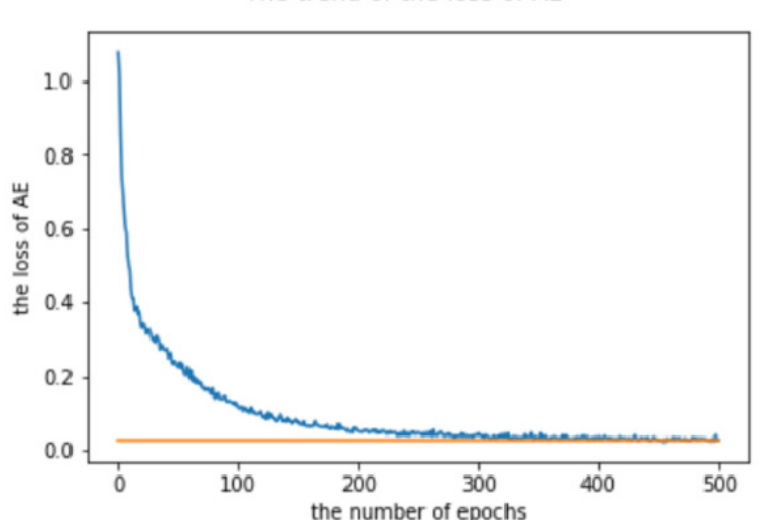
Figure 5. The trend of the loss of AE w.r.t. varying values of the number of